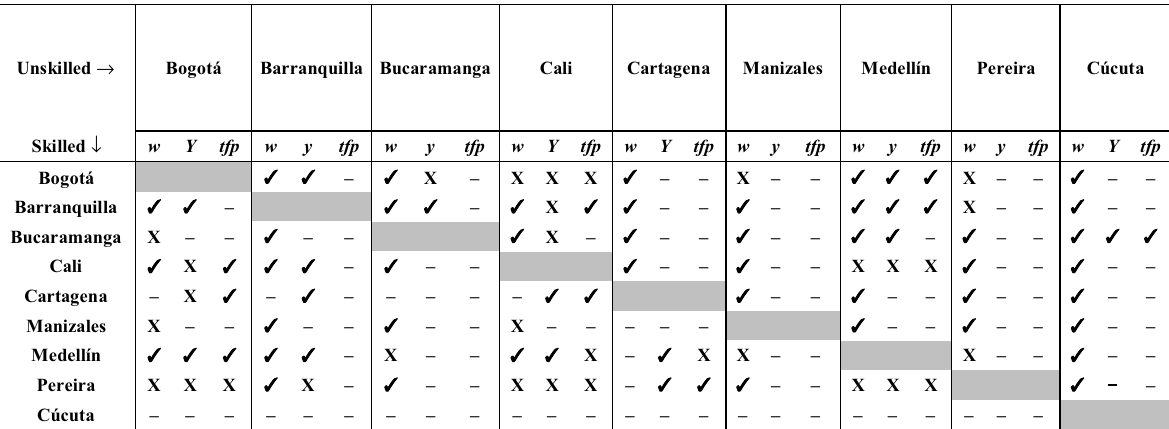
Table 2 Geographical homogeneity test on conditional labour demand for permanent workers. Source Dane-AMS; authors’ calculations